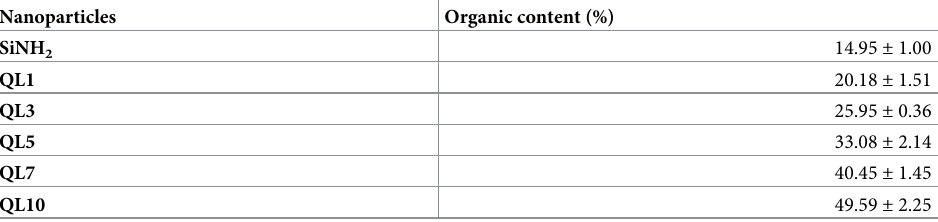
Table 1. Percentage of organic matter in silica nanoparticles layered with different number of quadruple layers containing chlorhexidine determined from TGA (n = 3 ±